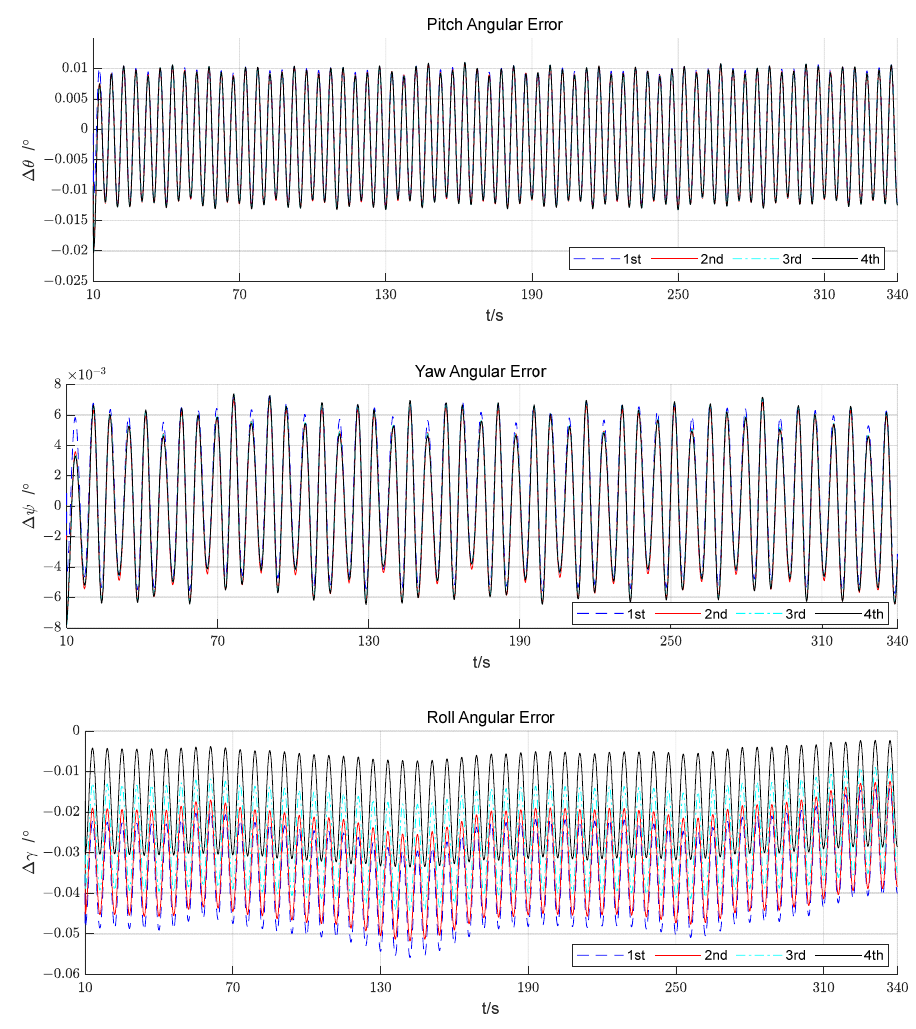
Figure 8. Curves of attitude errors.